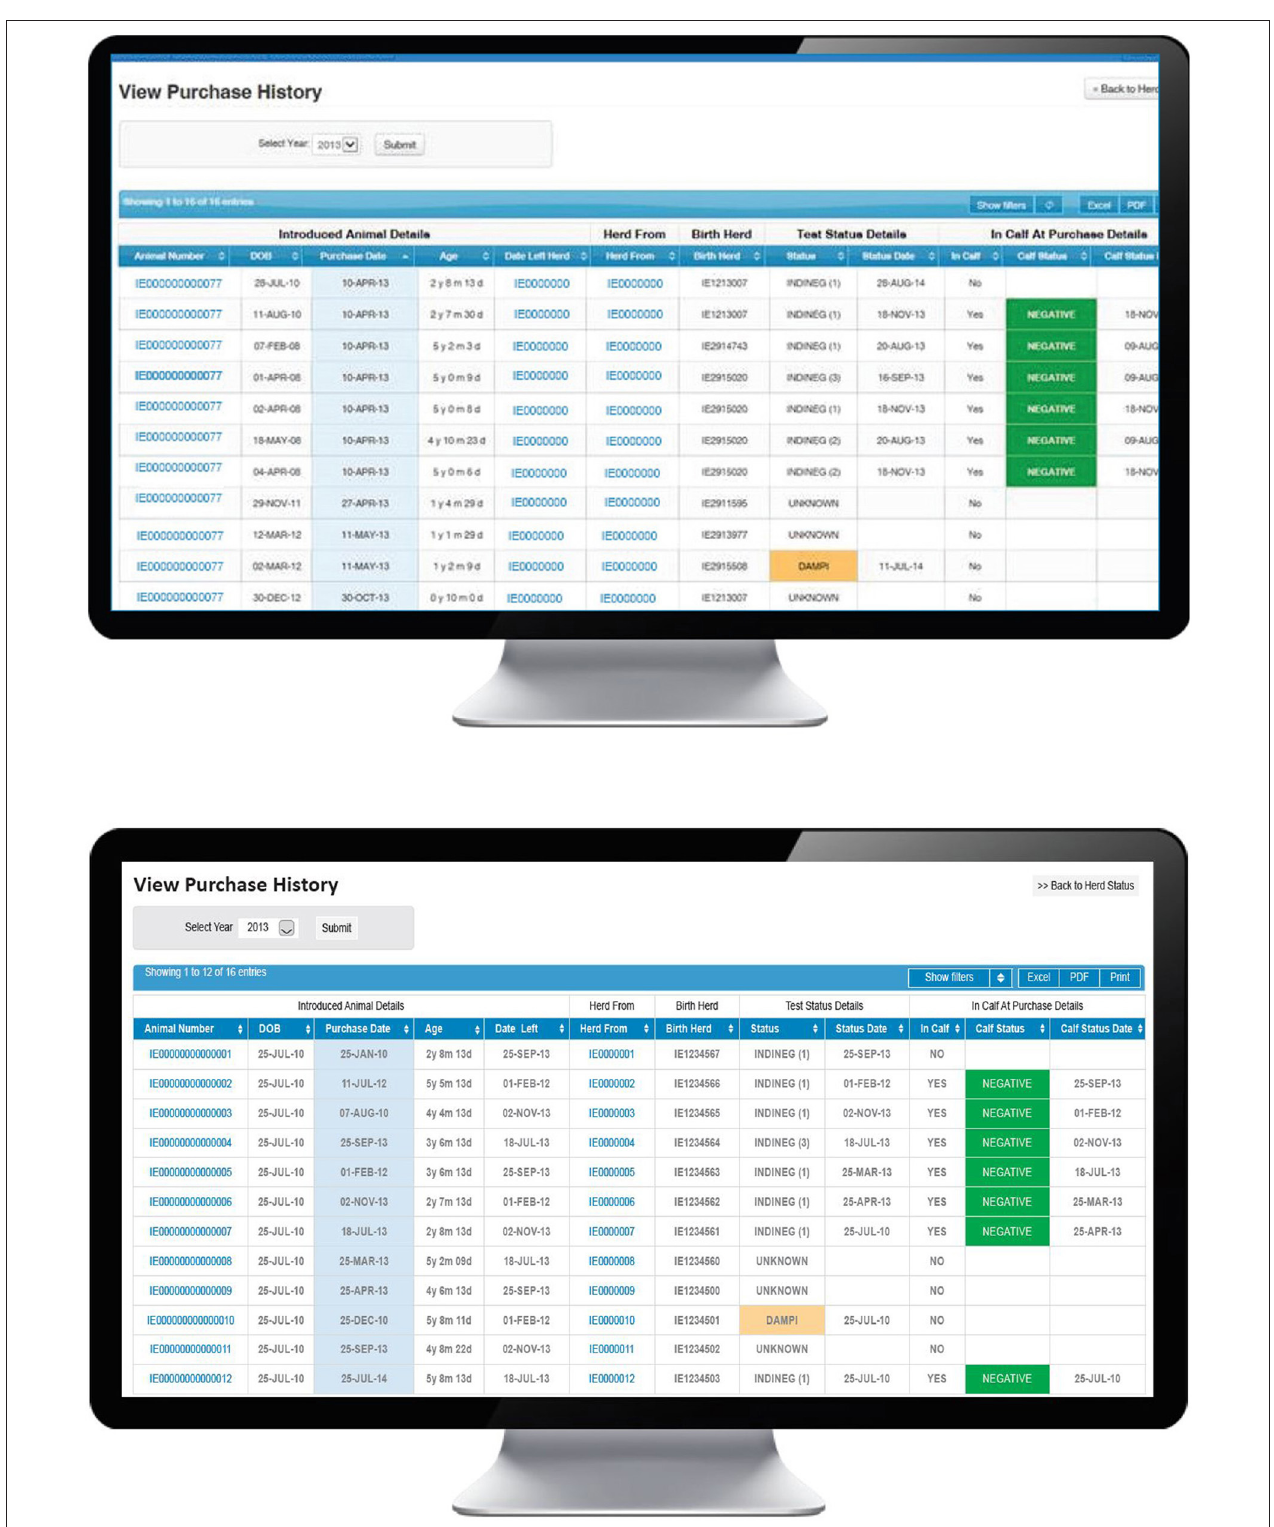
FIGURE 5 | Purchase history screen on the BVD herd-level dashboard provided by ICBF, listing details of introduced animals including purchase date, pregnancy status at purchase, and their current test status.